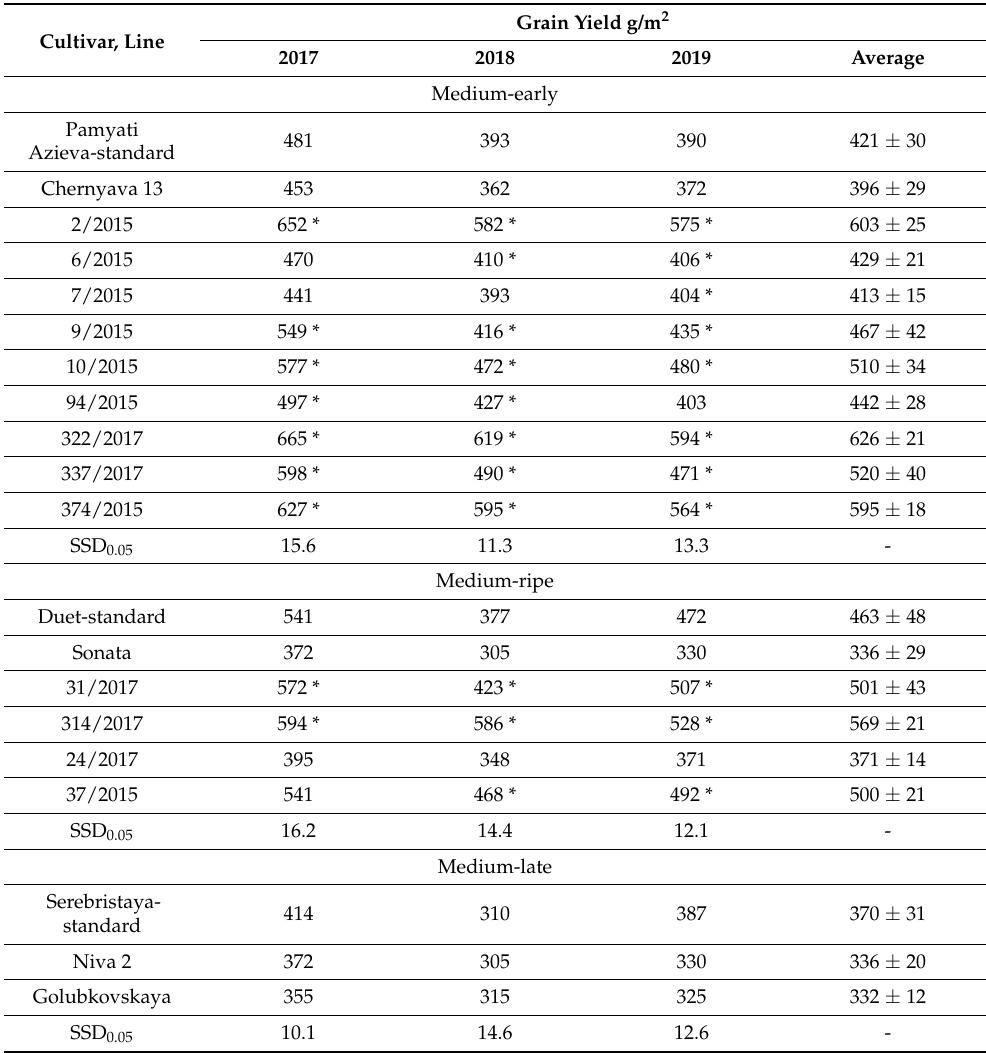
Table 3. Grain yield of spring common wheat cultivars and introgressive lines with genetic material of Thinopyrum ponticum on Septoria blotch natural infection background (Omsk, Russia, 2017–2019). Cultivar,